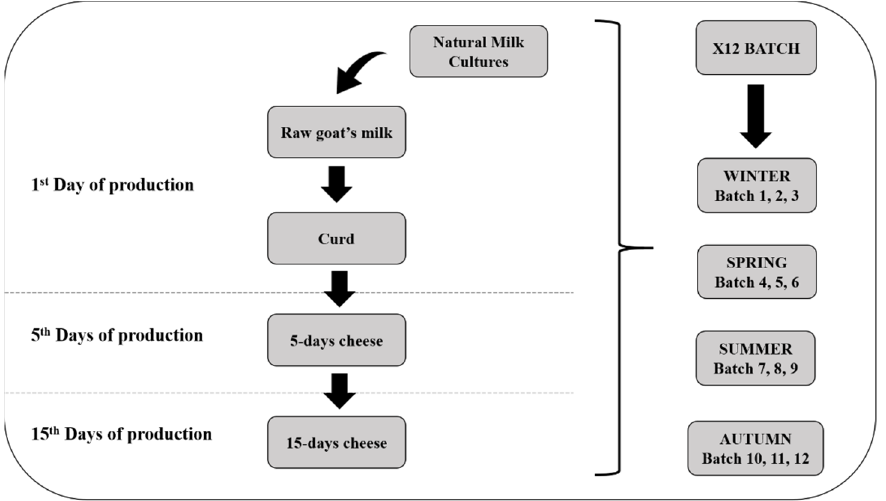
Figure 1. Representative scheme of sampling procedures during the principal production steps of Robiola di Roccaverano cheese.